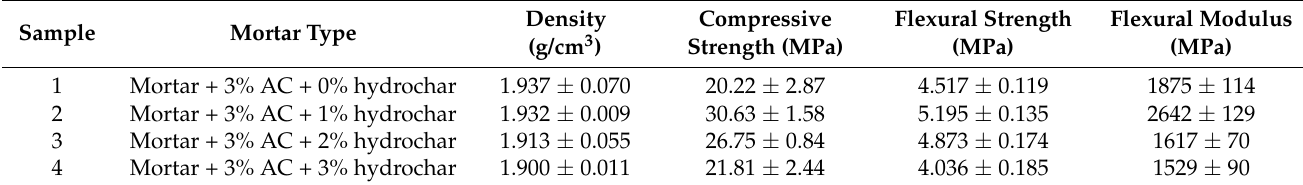
Table 8. The mechanical properties of the mortar with 3% activated charcoal and hydrochar at various